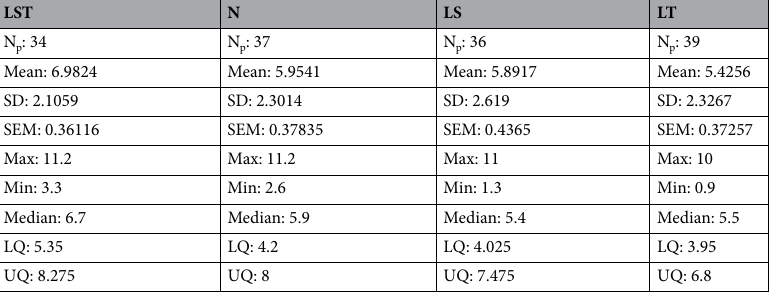
Table 1. Basic statistics of slope values. The basic statistic is shown for each condition separately (from left to right: LST, N, LT, LS). N p represents the number of participants included in the condition. The Mean, SD (standard deviation), SEM (standard error of the mean), Max (maximum slope), Min (minimum slope) and the Median are listed. LQ shows the lower quartile and UQ shows the upper quartile.